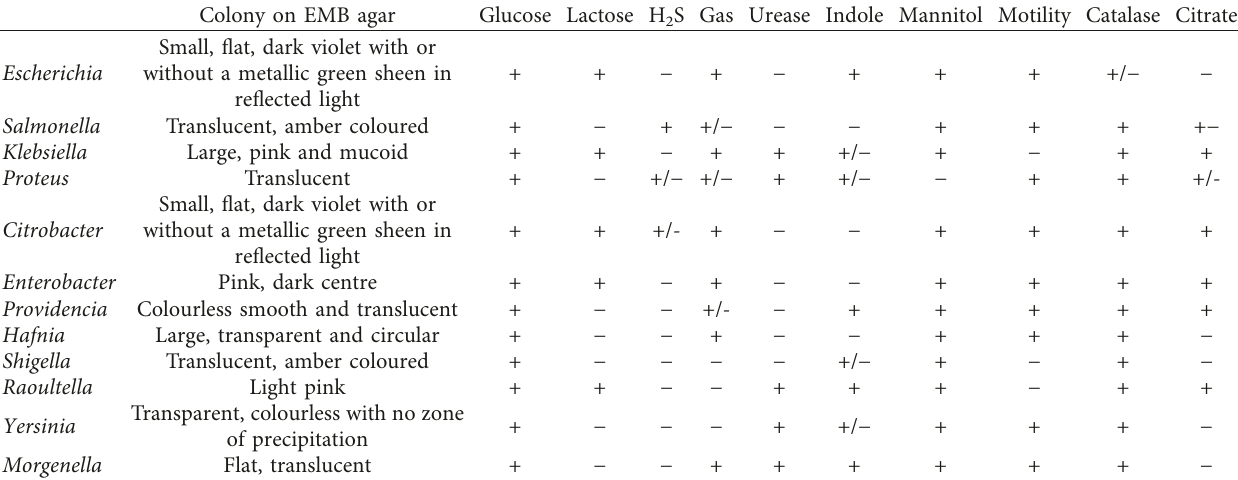
Table 3: Colony aspect and biochemical reactions of the isolated